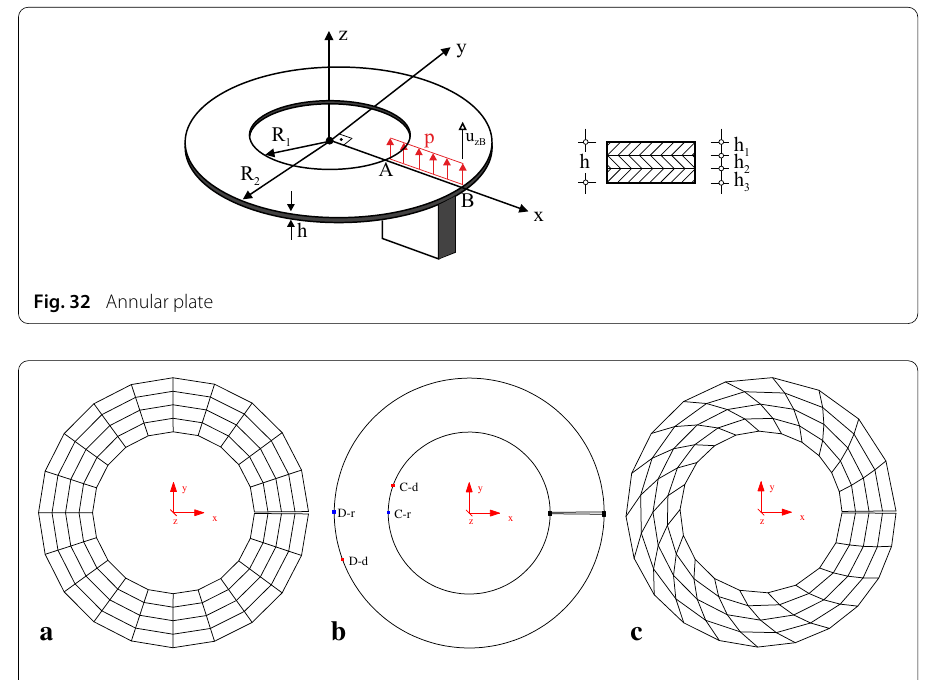
Fig. 32 Annular plate